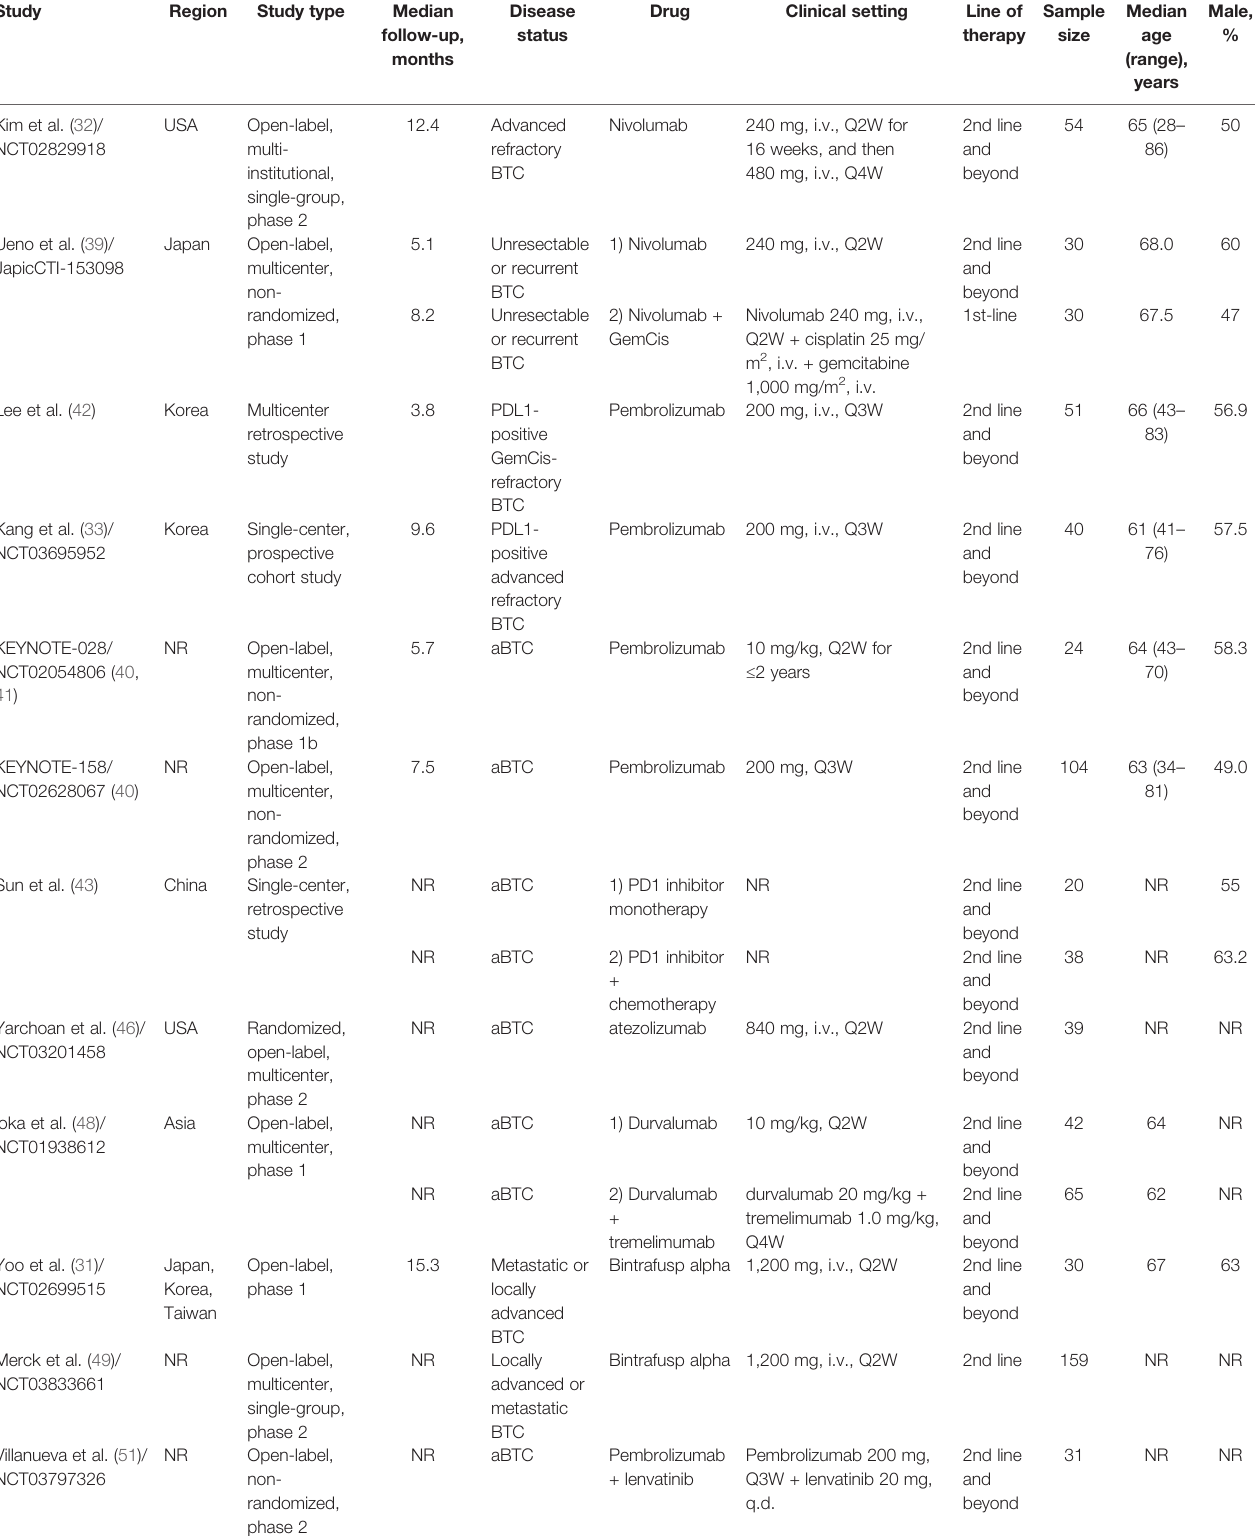
TABLE 1 | Baseline characteristics of included studies with anti-PD1/PDL1 in